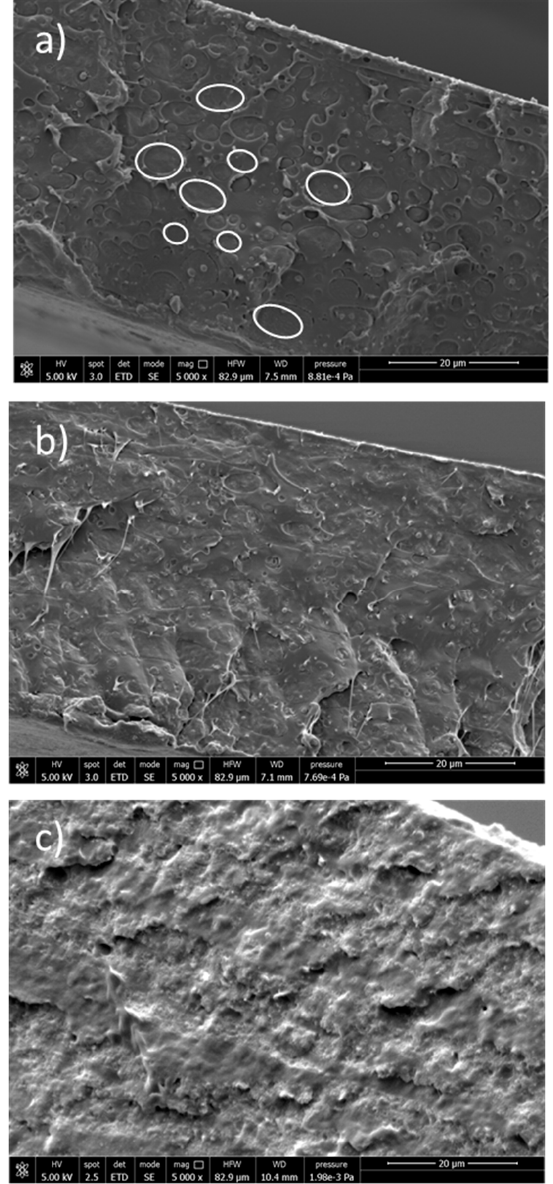
Figure 7. SEM images of PLA/PBS 60/40 wt.% blend ( a ), PLA/PBS/LDH-DS/RA ( b ), PLA/PBS/LDH- SEM images of PLA/PBS 60/40 wt.% blend ( a ), PLA/PBS/LDH-DS/RA ( b ), DS/GA ( c ). PLA/PBS/LDH-DS/GA ( c